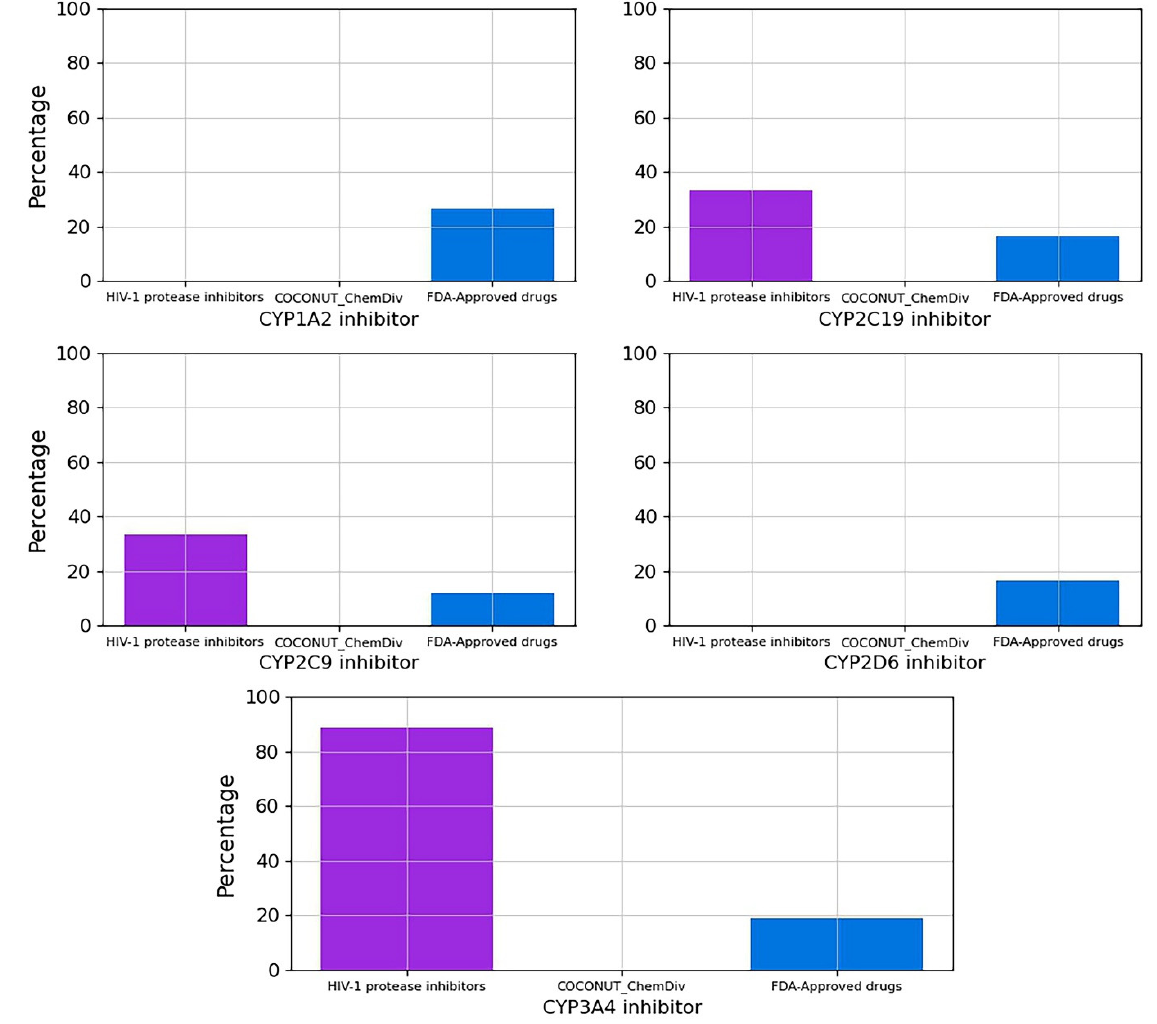
Figure 13. Percentage of compounds that inhibit the main cytochromes, CYP1A2, CYP2C19, CYP2C9, CYP2D6, CYP3A4. Colors represent compounds: new chemical compounds generated from COCONUT fragments and ChemDiv fragments with physicochemical properties like FDA-approved HIV-1 protease inhibitors and easily synthetically accessible, FDA- approved drugs (blue), FDA-approved HIV-1 protease inhibitors (purple).